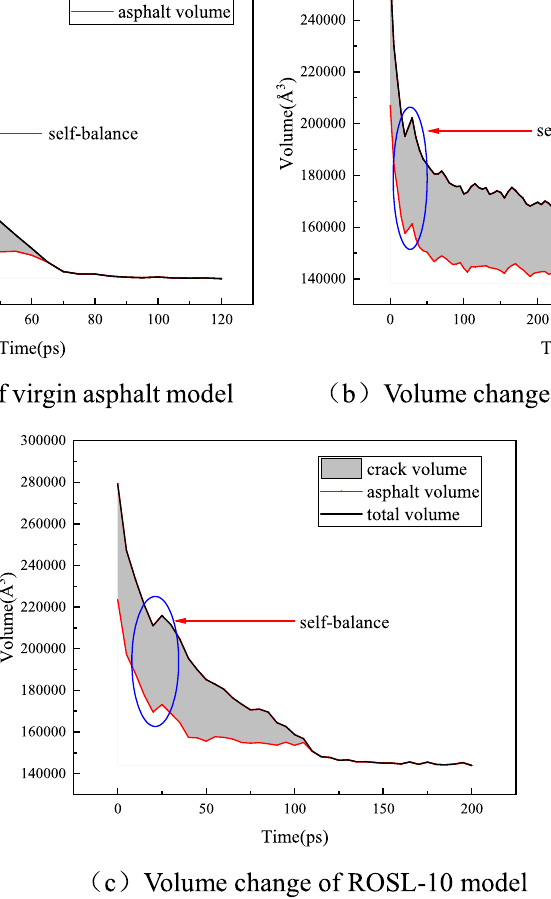
Figure 9. Volume change of virgin asphalt, aged asphalt and ROSL-10 models during self-healing